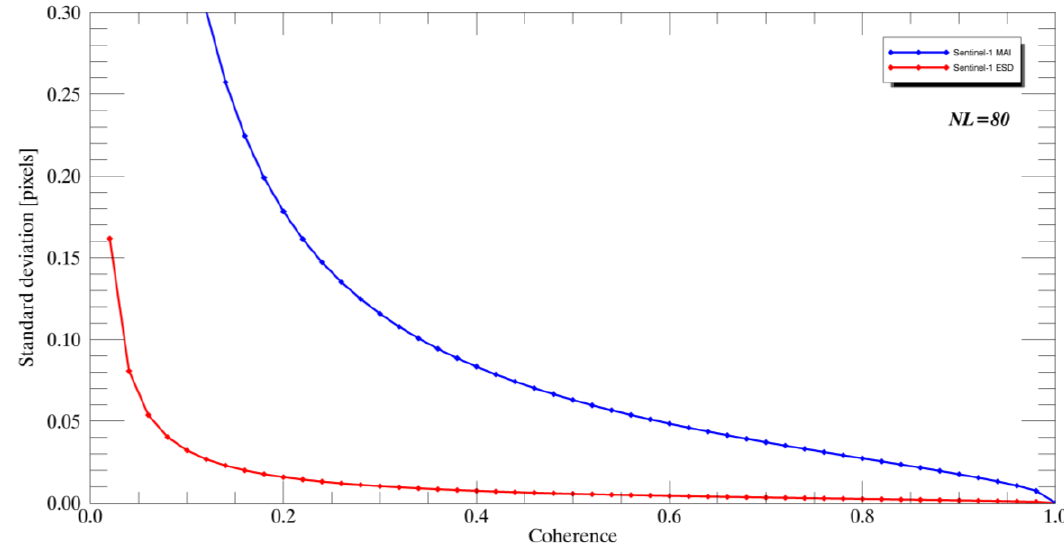
Figure 21. Cross-comparison of MAI (blue line) and ESD (red line) root mean squared error (RMSE) vs coherence. NL indicates effective look numbers.